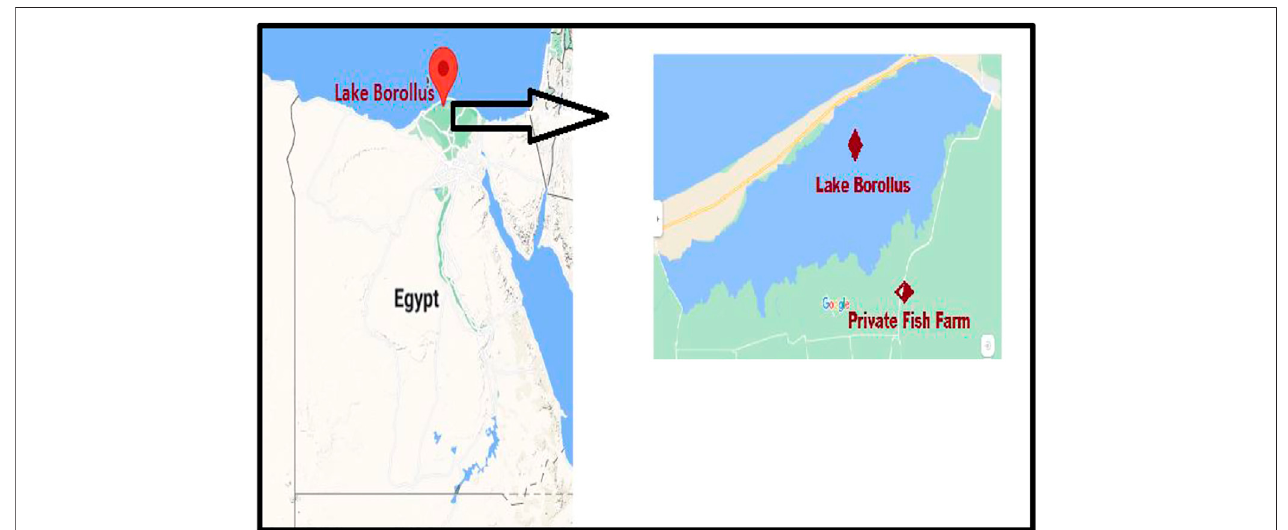
FIGURE 1 | Map showing the Burullus Lake and the Private Fish Farm